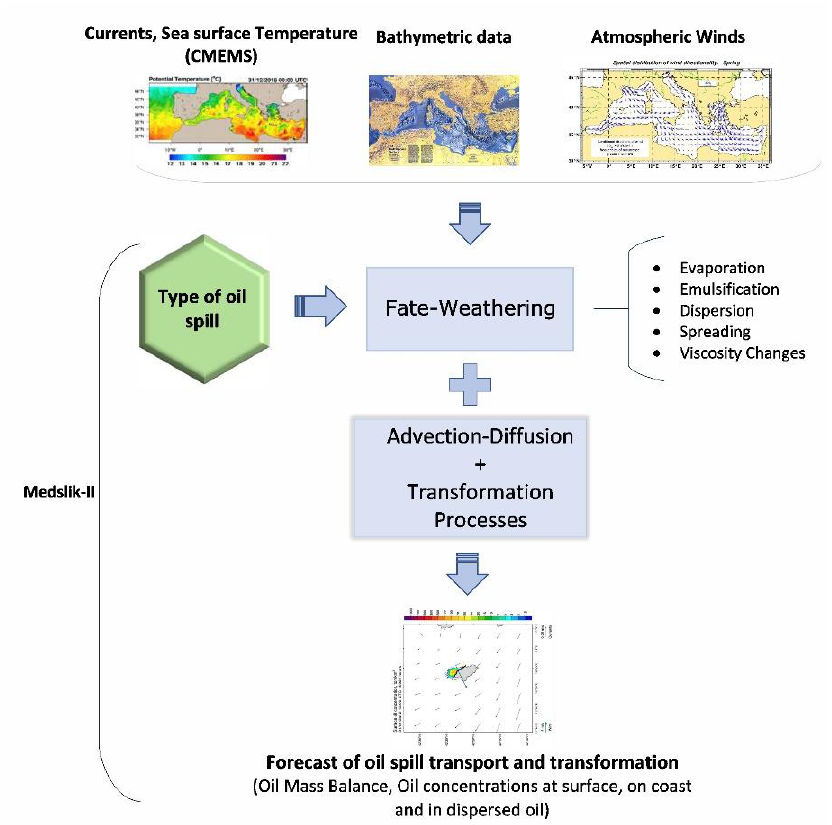
Figure 2. Schematic diagram of MEDSLIK-II model with input and output